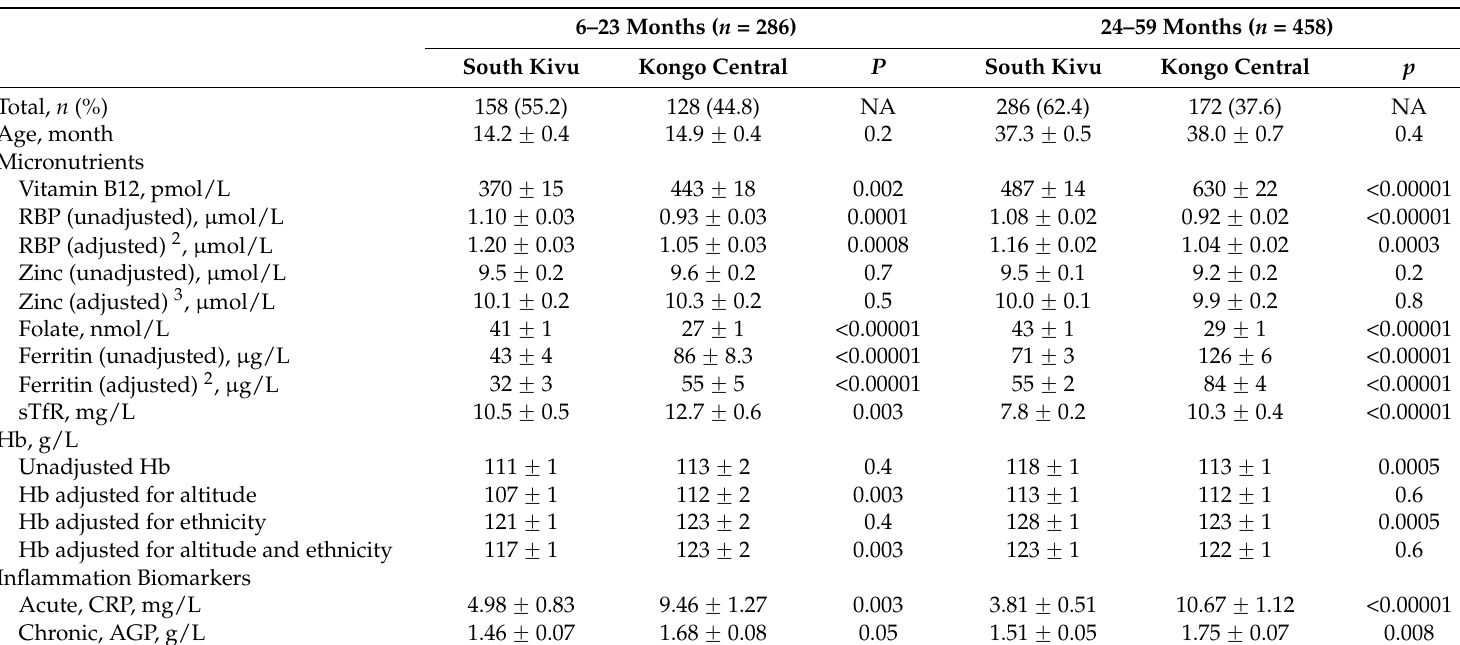
Mean ˘ SEM age and concentration of micronutrients, hemoglobin, and inflammation biomarkers among children 6–23 and 24–59 months ( n = 676–741 children) by province 1